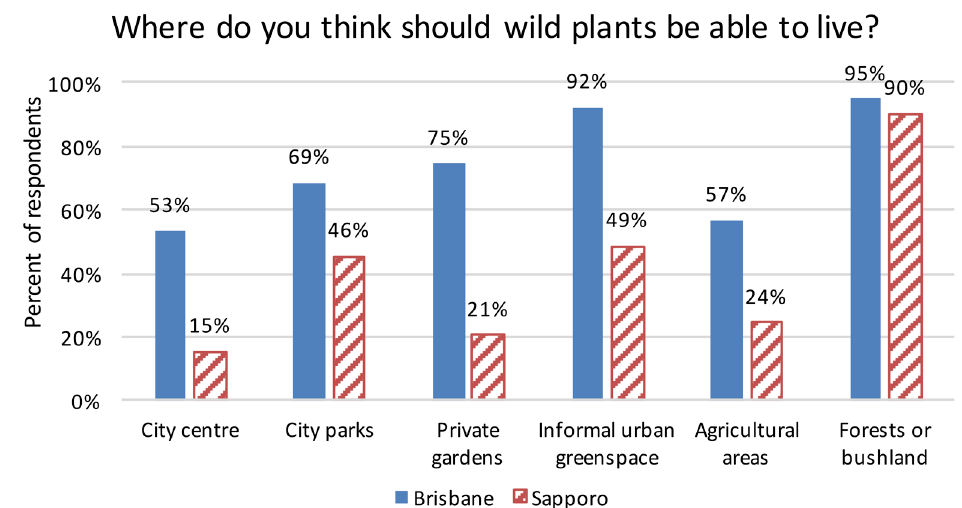
Fig. 4. Brisbane and Sapporo respondents’ perceived places of belonging for